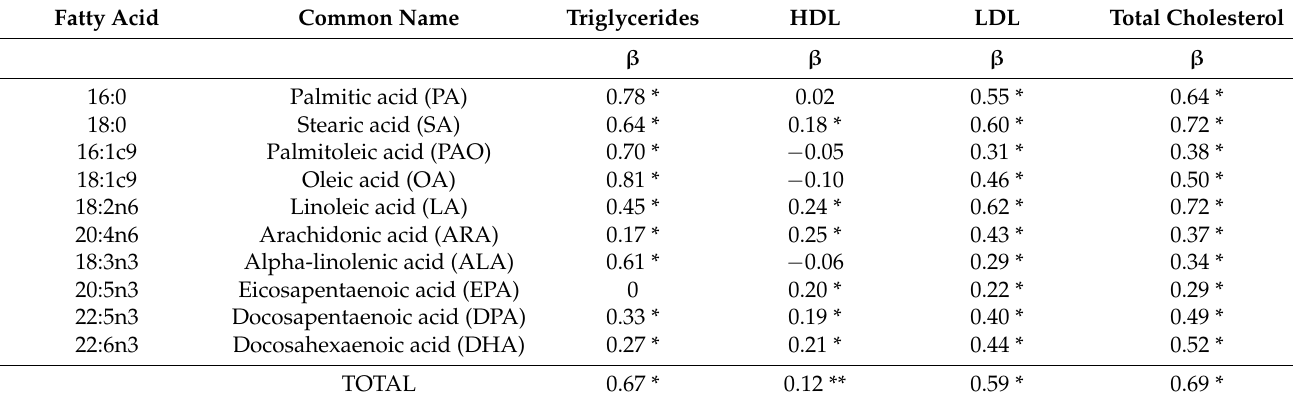
Table 5. Multiple regression model assessing the unique variance between select fatty acids and lipid biomarkers. Fatty Acid